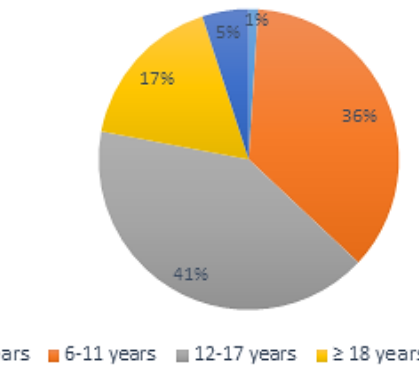
Figure 2. Schematic distribution of acute confusional migraine among different age groups. The figure shows two-thirds (75%) of the cases occur in people aged <18 years.